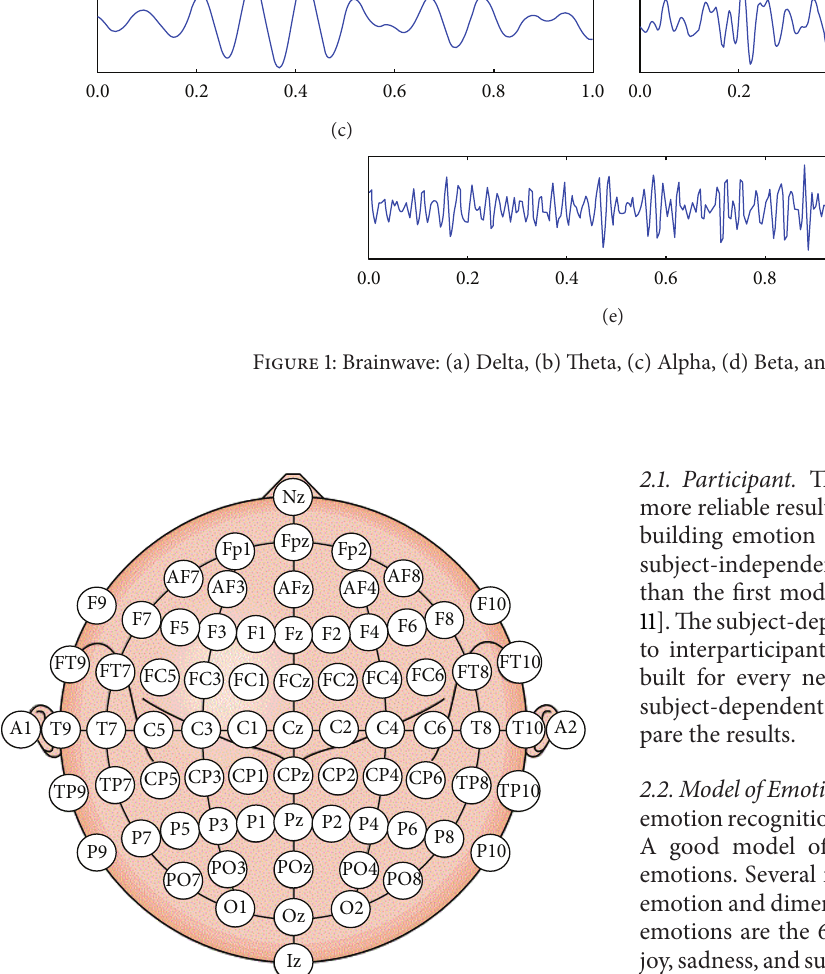
Figure 2: International 10–20 system of electrode placement